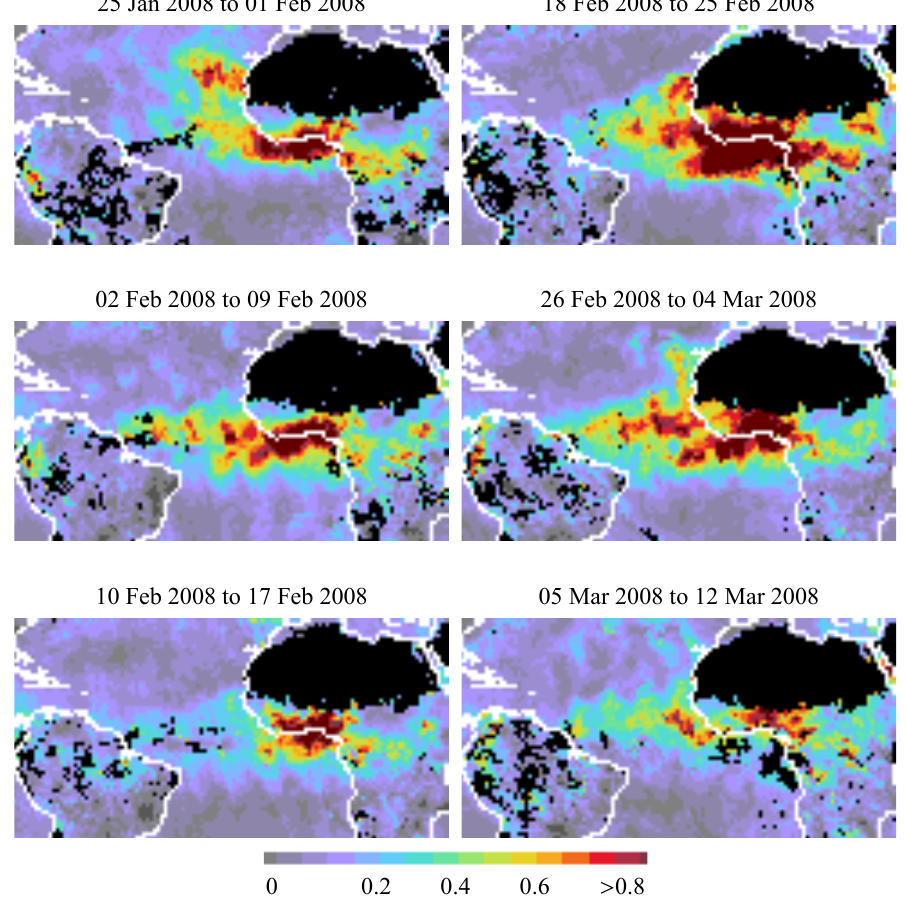
Fig. 7. Particle optical depth observed by the MODIS instrument on the AQUA satellite (Levy et al., 2007; Remer et al., 2008). Shown are the level-3 eight-day composites of Collection 5.